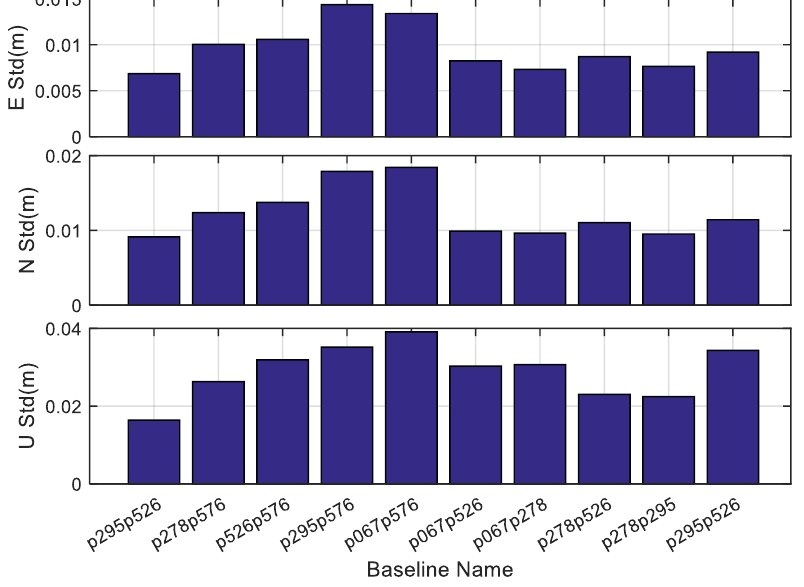
Figure 12. RTK positioning precision with the FL-approach ( η = 0.99 case).